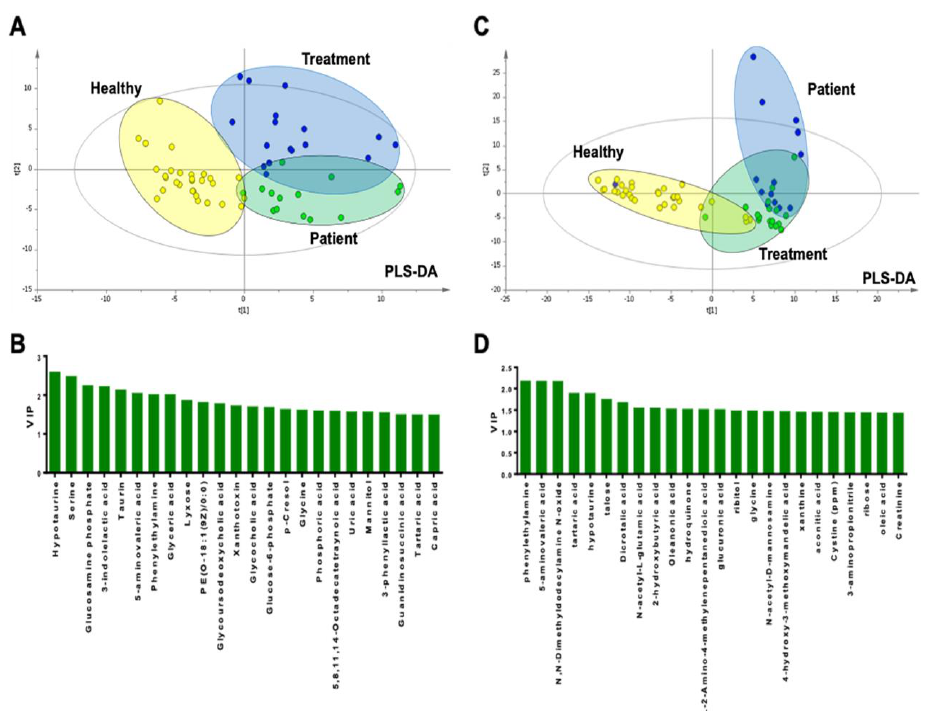
Figure 1. Multivariate analysis of data obtained from plasma (left panel) and urine (right panel) metabolomics. ( A , C ): PLS-DA score graphs; ( B , D ): VIP graphs showing the most important metab- olites leading to differences in data analysis.